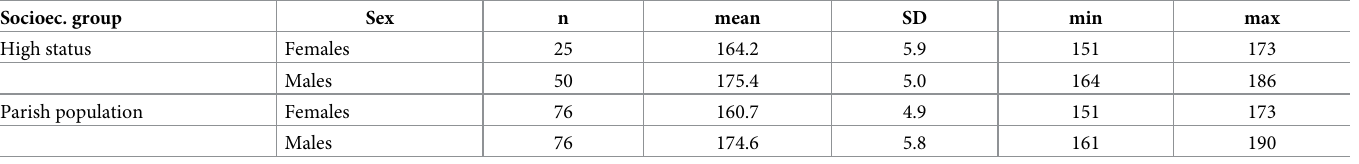
F: females and M: